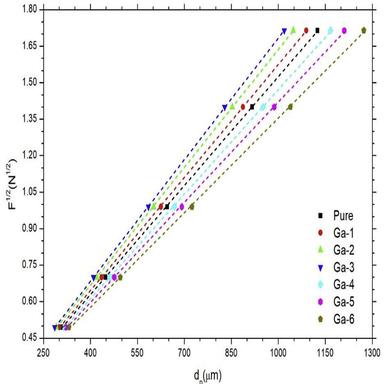
Extrapolation curves between applied test load F1/2 and diagonal length dp for every material studied.